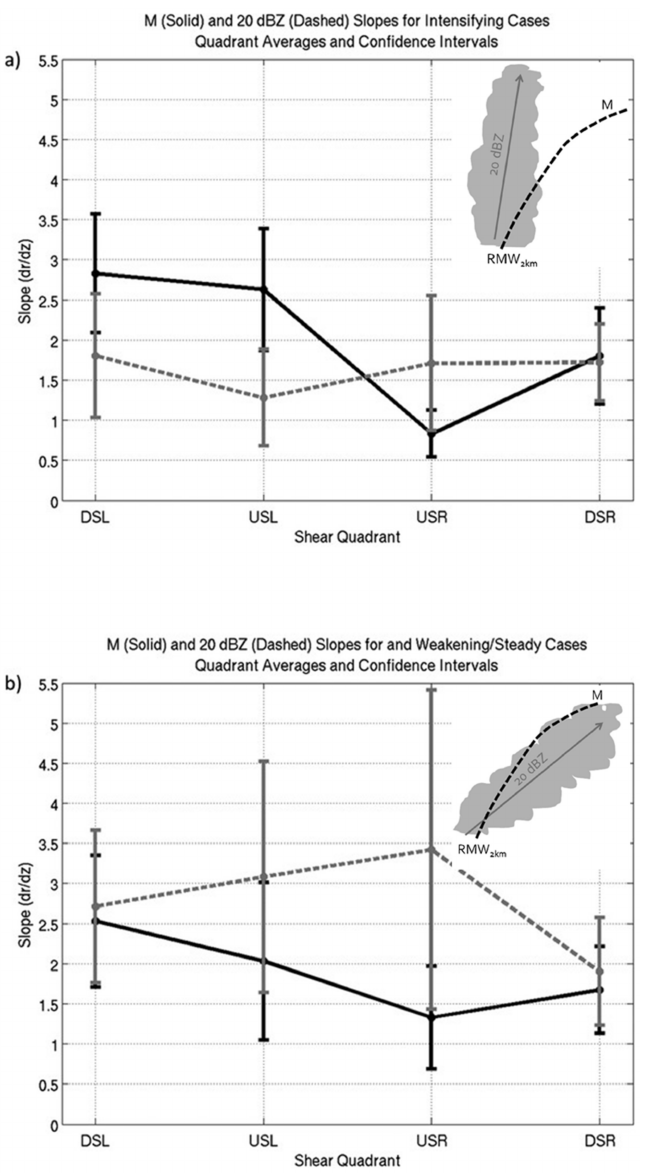
Figure 9. Average and 95% confidence intervals of the M (solid) and 20-dBZ (dashed) slopes for ( a ) intensifying and ( b ) weakening/steady cases. Higher (lower) values of slope denote a more sloped (upright) configuration. Inset in each panel shows schematic illustrating relationship between momentum and reflectivitym surfaces for each intensity change category. Adapted from Hazelton et al.